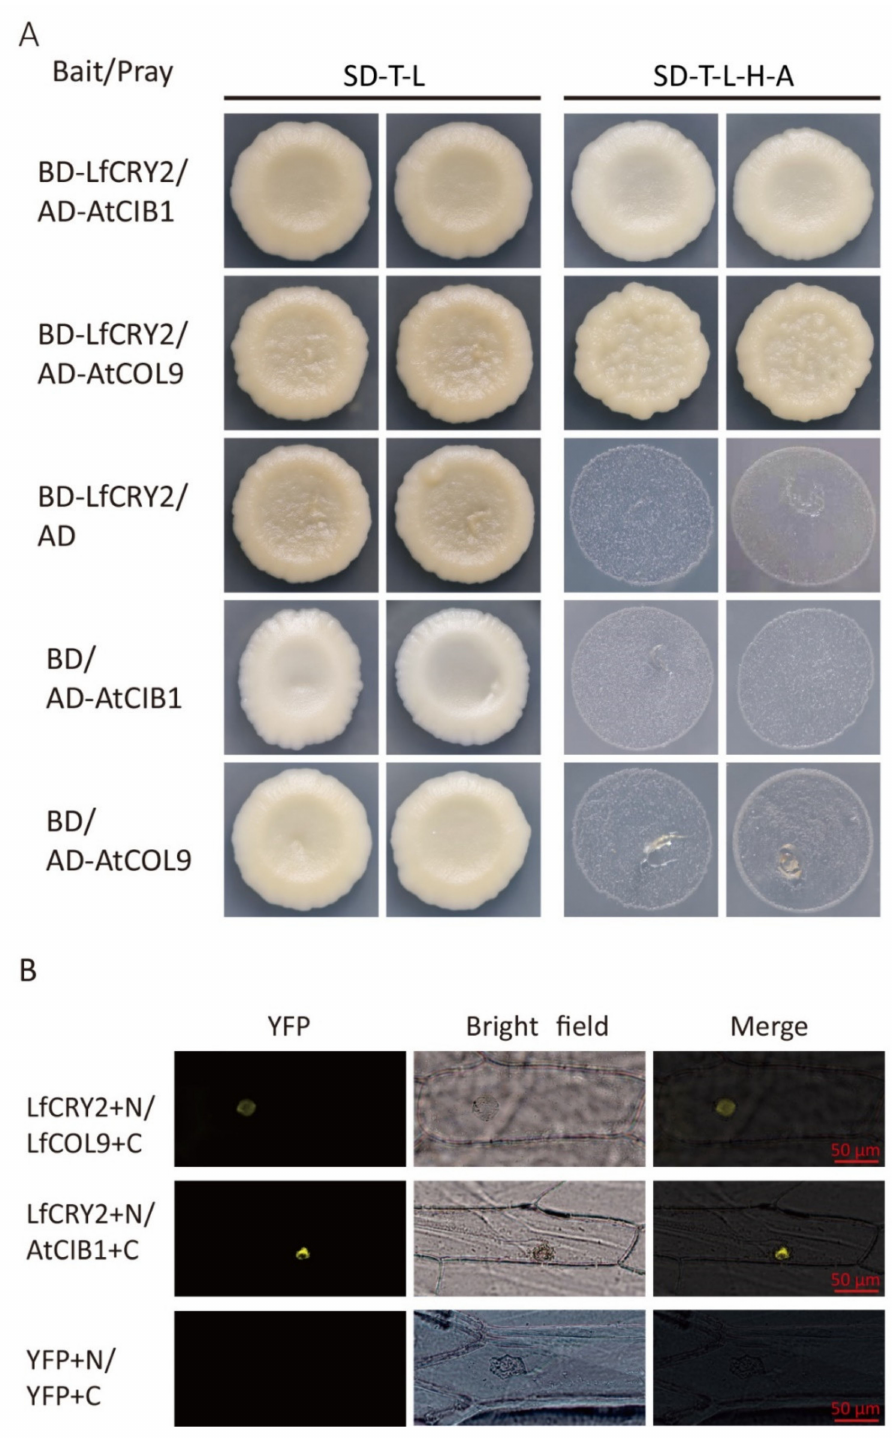
Figure 7. LfCRY2 physically interacts with LfCOL9 and AtCIB1 in yeast and onion cells. ( A ) Yeast two-hybrid showing the interaction of LfCRY2 with LfCOL9 and AtCIB1. Yeast cells coexpressing the indicated combinations of constructs were grown on nonselective (SD-T-L) or selective media (SD-T-L-H-A). ( B ) Bimolecular fluorescence complementation (BiFC) assays indicating the interaction of LfCRY1 with LfCOL9 and AtCIB1 in onion